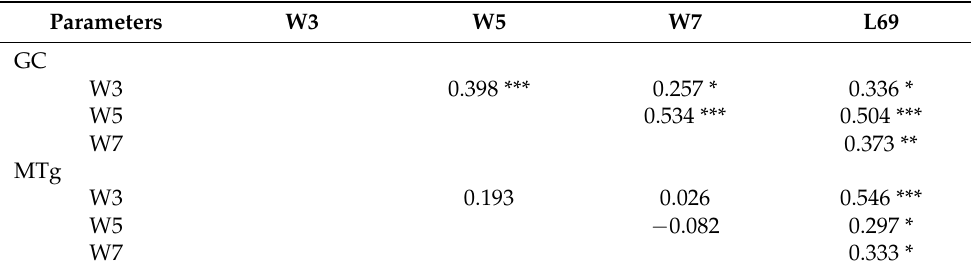
Table 4. Correlation coefficients of residuals of depths of the mammary gland cistern (GC) and